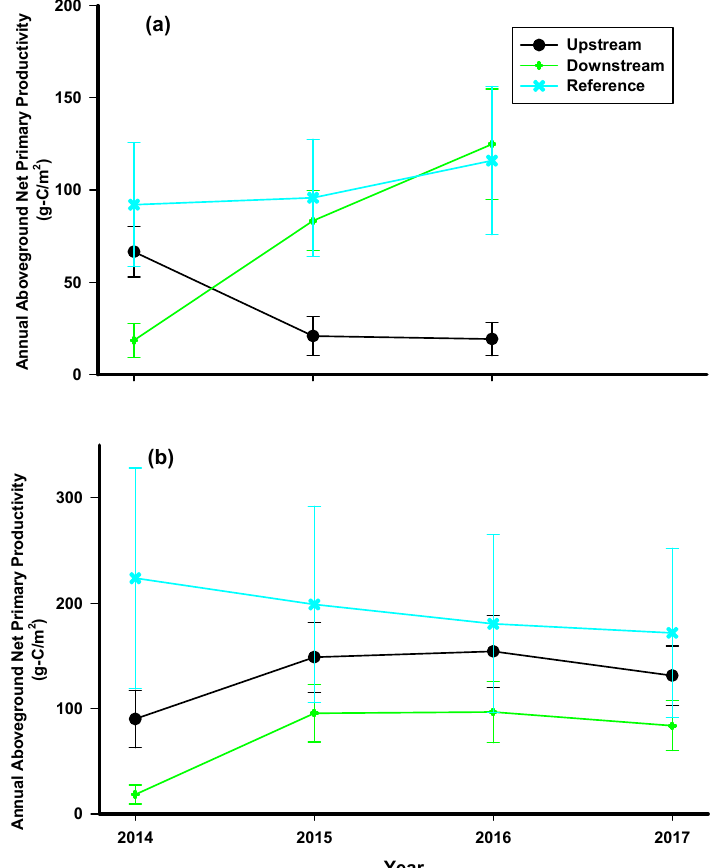
1 Different superscript letters in a column represent the significantly different mean NPPag between groups (e.g., Downstream vs. Upstream; Downstream 2 m vs. Downstream 6 m, etc.) within the bog or fen (p < 0.05).